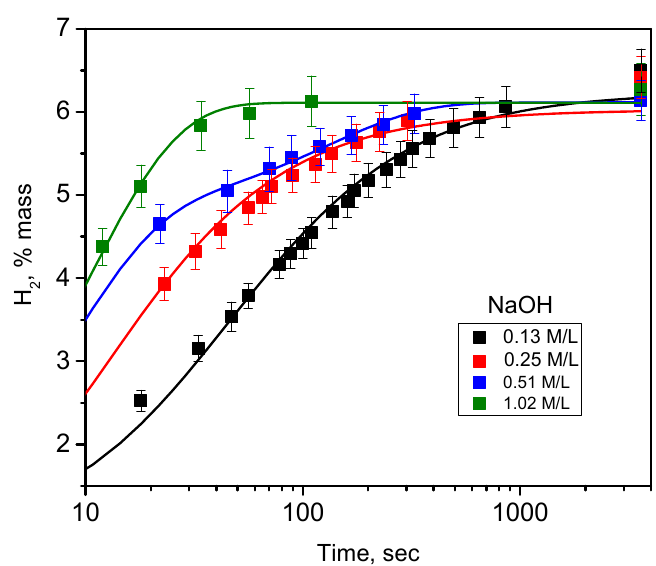
Figure 6. Kinetics of hydrogen generation due to oxidation reaction of meso-PSi nanopowders in water:ethanol:NaOH solutions at different concentrations of the alkali. Discrete points correspond to experimentally measured values, while solid lines are the fitting functions given in Supplementary Materials.